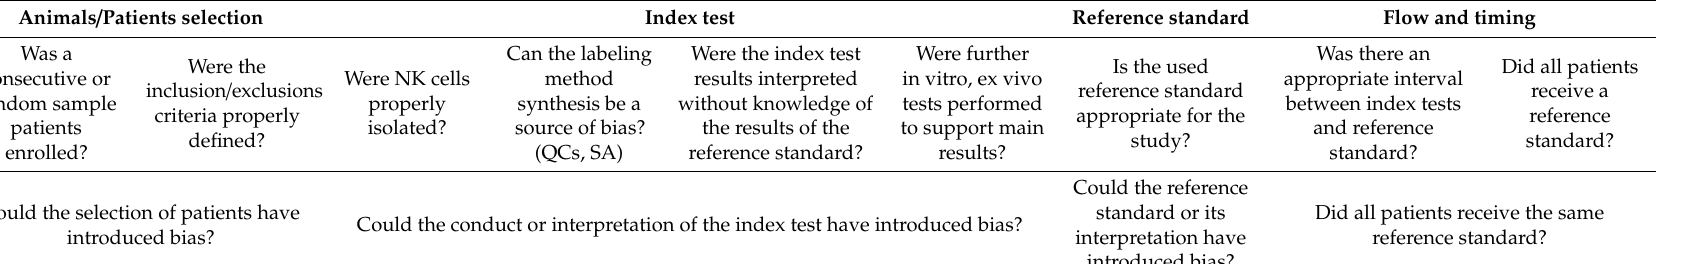
Table A1. QUADAS-2 questionnaire for evaluation of included